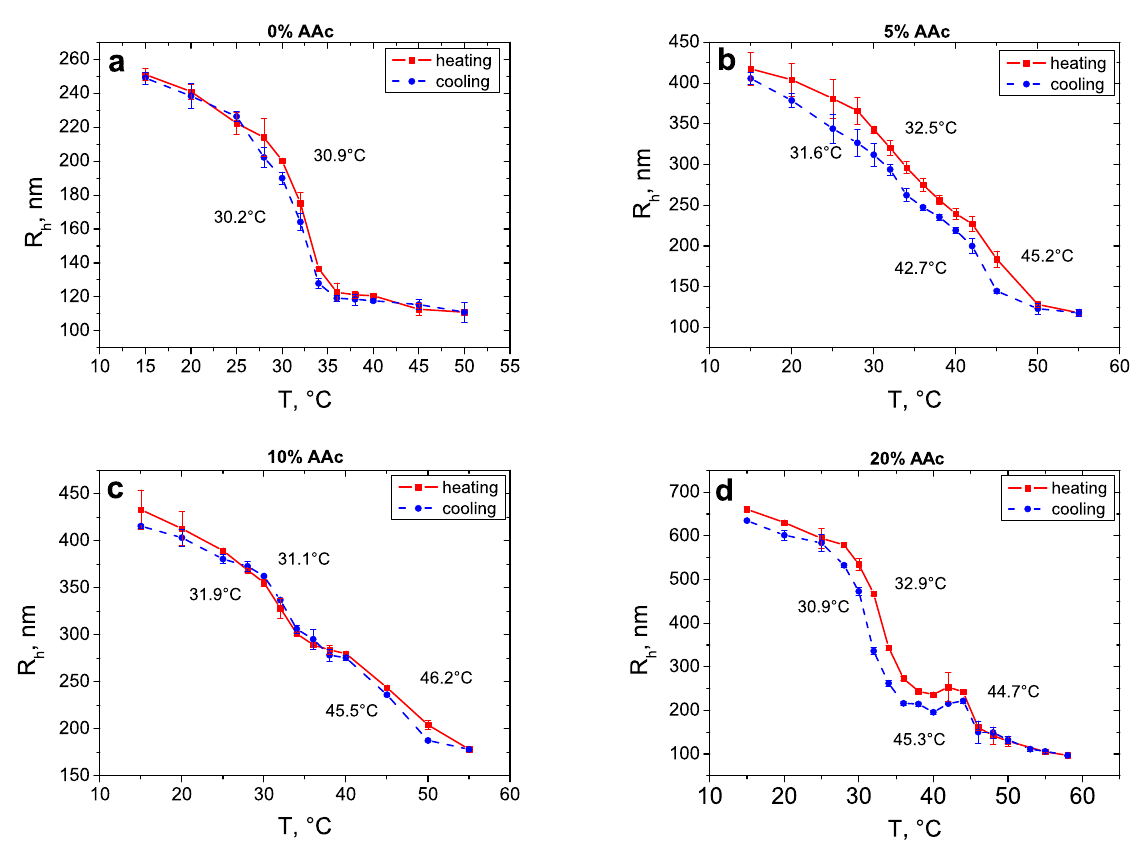
Figure 1. Temperature dependence of the hydrodynamic radii of microgel particles with 0% (a) ; 5% (b) ; 10% (c) ; and 20% (d) AAc contents measured by DLS. The temperature values refer to the volume phase transition during the heating (squares) and cooling (circles) process,